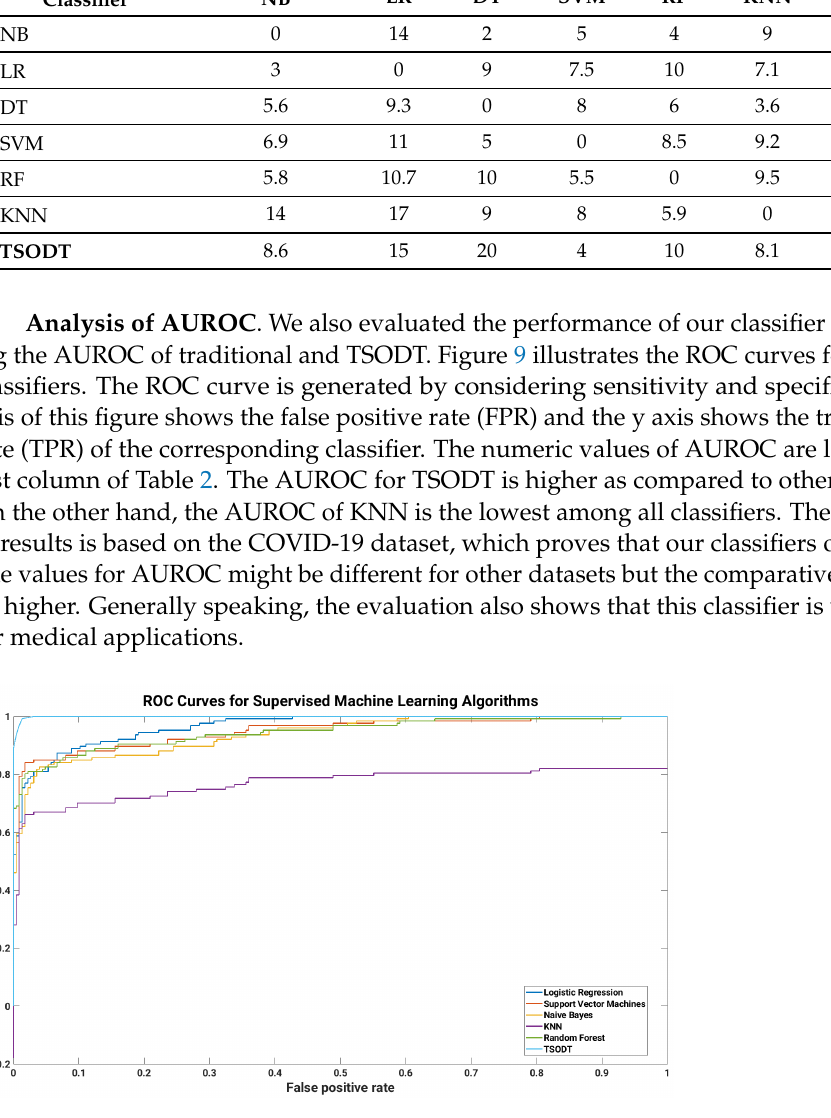
Figure 9. Performance validation (based on AUROC) of our proposed TSODT